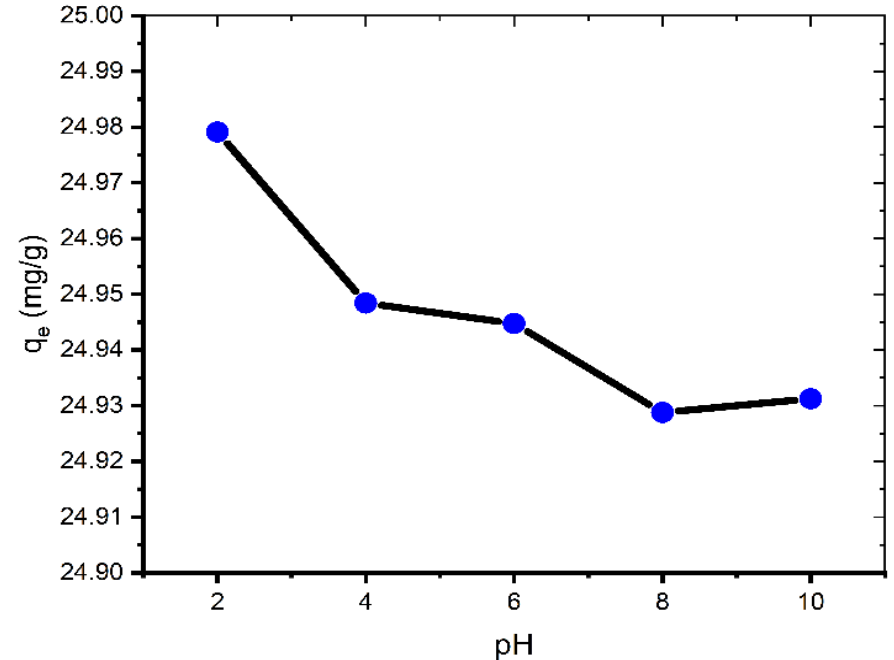
Figure 3. Effect of pH on adsorption of MB onto coal (contact time = 60 min; C 0 = 100 mg L − 1 ; mass of coal = 0.1 g; volume of MB solution = 25 mL; T = 299.15 K).